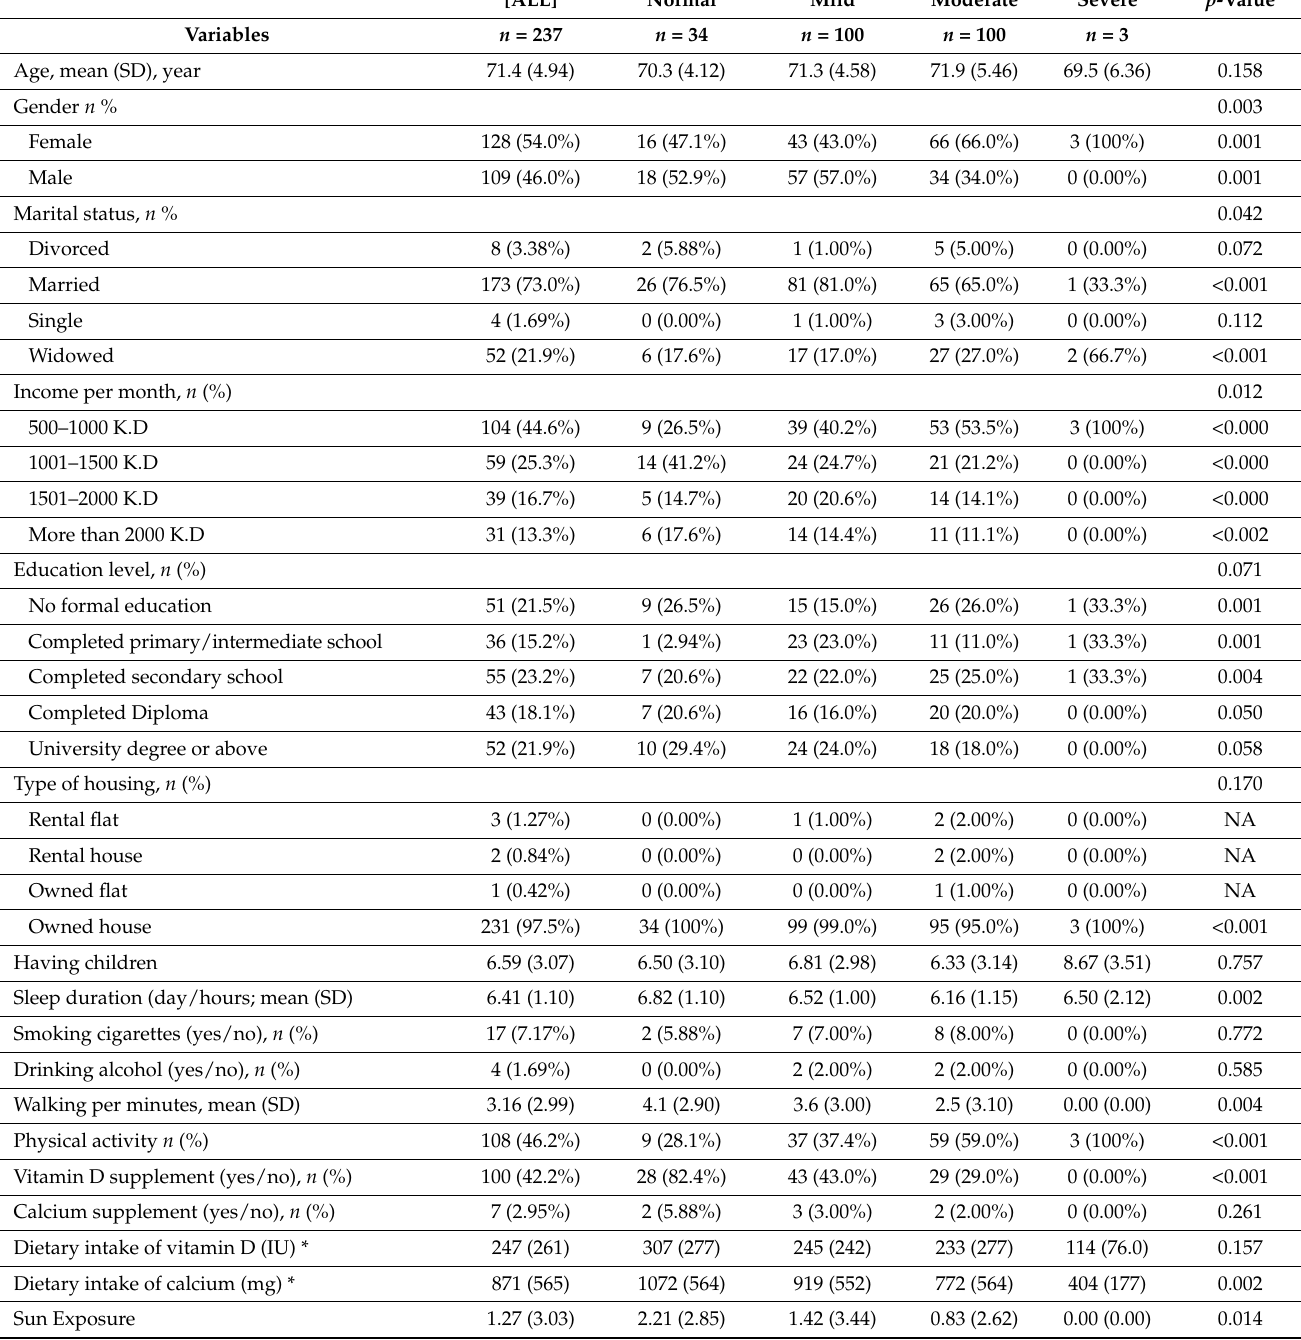
Table 1. Social demographic factors associated with symptoms of depression (GDS-15) among the study